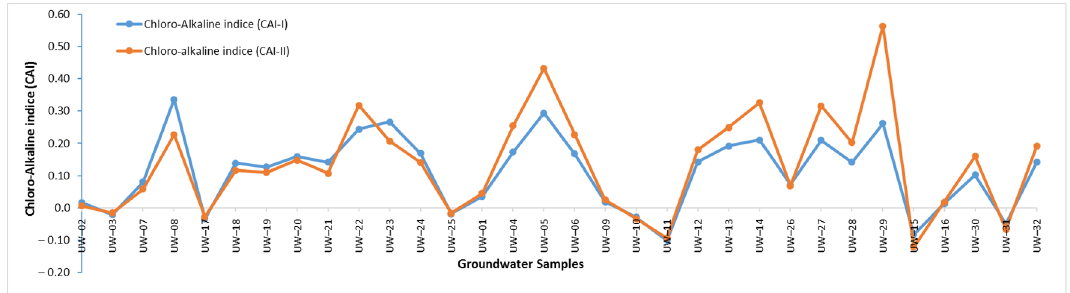
Figure 8. Chloro-alkaline indices (CAI) of analyzed groundwater